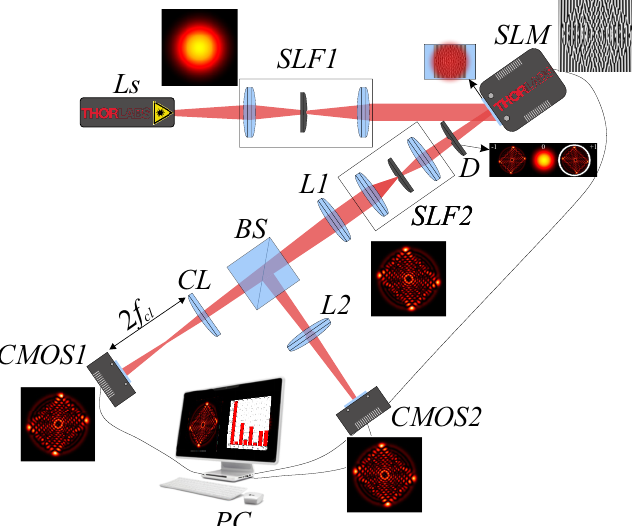
Figure 8. Sketch of the experimental setup: Ls—He–Ne laser ( λ = 0.633 µ m), SLF1,2—spatial light filter, SLM—spatial light modulator, L1, L2—spherical lenses with f sp = 25 cm (focus length), BS—beam splitter, CL—cylindrical lens with f cl = 15 cm, CMOS1,2—complementary metal-oxide- semiconductor detector,